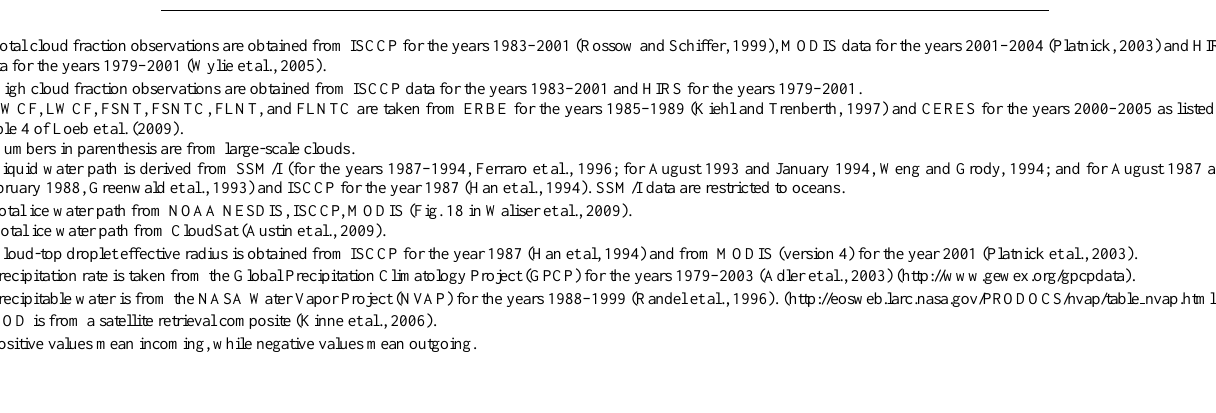
Table 4 of Loeb et al. (2009). d Numbers in parenthesis are from large-scale clouds. e Liquid water path is derived from SSM/I (for the years 1987–1994, Ferraro et al., 1996; for August 1993 and January 1994, Weng and Grody, 1994; and for August 1987 and February 1988, Greenwald et al., 1993) and ISCCP for the year 1987 (Han et al., 1994). SSM/I data are restricted to oceans. f Total ice water path from NOAA NESDIS, ISCCP, MODIS (Fig. 18 in Waliser et al., 2009). g Total ice water path from CloudSat (Austin et al., 2009). h Cloud-top droplet effective radius is obtained from ISCCP for the year 1987 (Han et al, 1994) and from MODIS (version 4) for the year 2001 (Platnick et al., 2003). i Precipitation rate is taken from the Global Precipitation Climatology Project (GPCP) for the years 1979–2003 (Adler et al., 2003) (http://www.gewex.org/gpcpdata). j Precipitable water is from the NASA Water Vapor Project (NVAP) for the years 1988–1999 (Randel et al., 1996). (http://eosweb.larc.nasa.gov/PRODOCS/nvap/table nvap.html). k AOD is from a satellite retrieval composite (Kinne et al., 2006). l Positive values mean incoming, while negative values mean